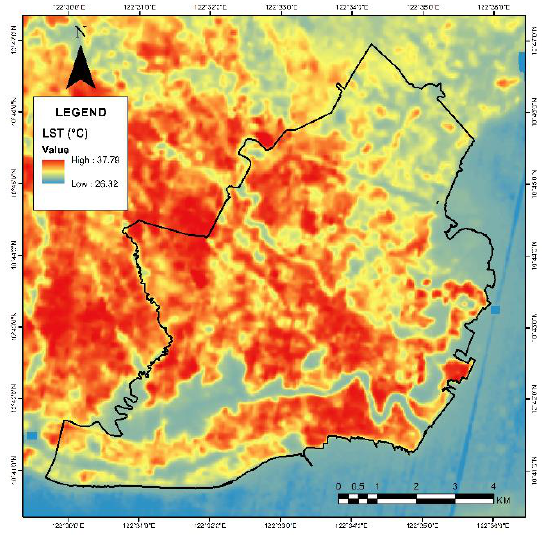
Figure 8. Landsat-derived LST map of Iloilo City on May 14, 2019